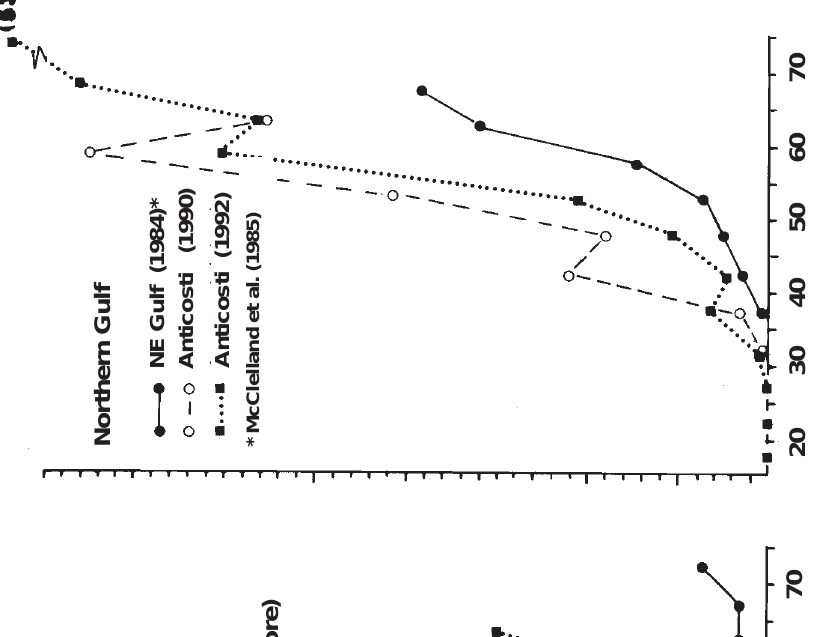
Fig. 5 Abundance (mean number per seal) of Contracaecum oscu- latum in grey seals (Halichoerus gry- pus), harp seals (Phoca groenlandi- ca), and harbour seals (Phoca vitulina) from various areas in the Gulf of St. Lawrence between 1988 and 1992. Numbers above each histogram refer to the sample size.